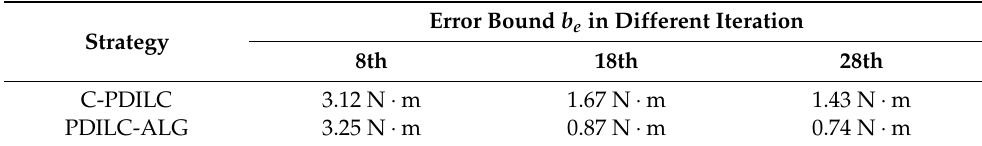
Table 4. Case 2 ( θ ∗ a ( t ) = 4 ◦ sin ( 4 π ih ) , y d ( t ) = 30sin ( 4 π ih ) ) experimental results of the two controllers.